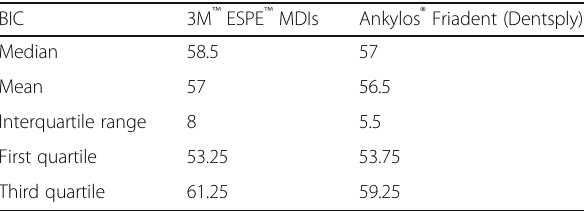
Table 2 Descriptive statistics of the experimental and control